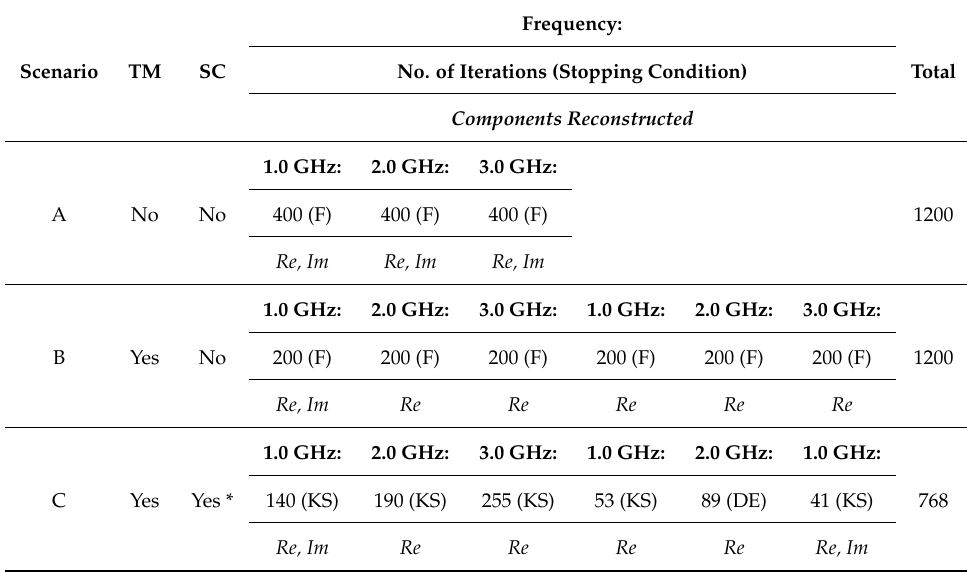
DE = Domain error; Re = Real part; Im = Imaginary part. * 80% of a 30-iteration data error window must reach or surpass a K-S test p -value threshold of